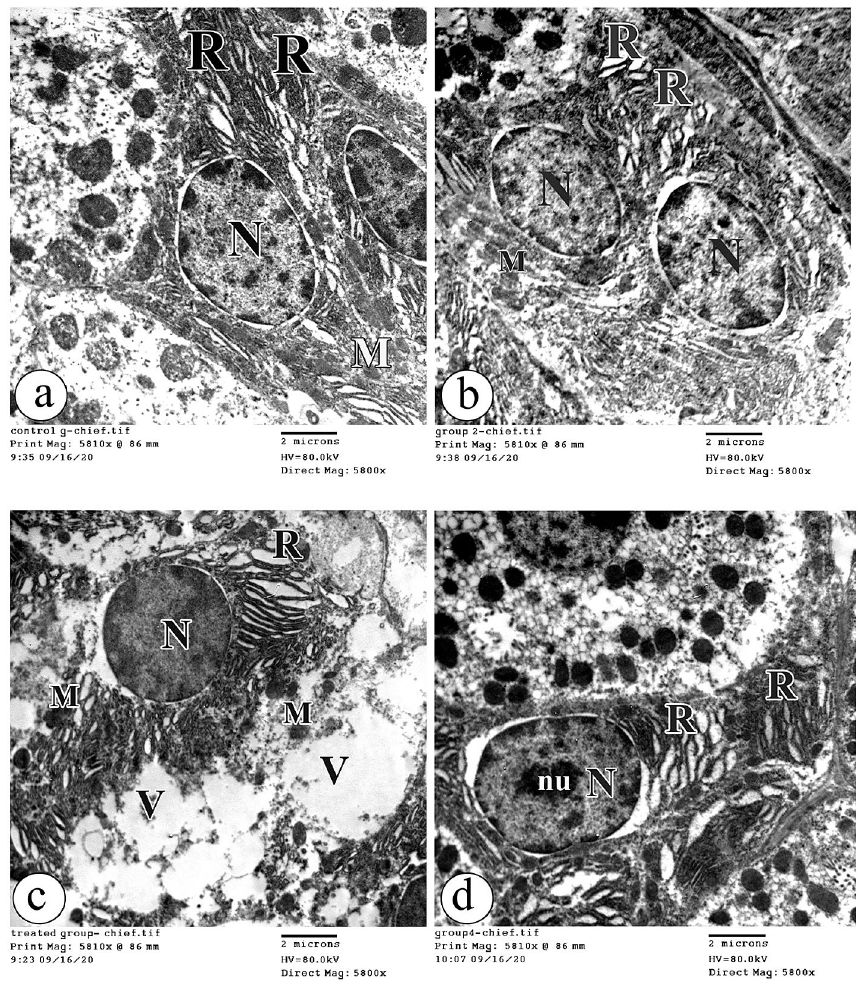
Figure 8. The electron photomicrographs of the Chief cell in ( a ) the group Ӏ showing an euchromatic nucleus (N), mitochondria (M) and an abundant packed rough endoplasmic reticulum (R). ( b ) the group ӀӀ showing an ultrastructural morphology as in the group Ӏ . ( c ) the group ӀӀӀ showing an electron dense nucleus (N), electron dense mitochondria (M) and many vacuolations (V). Dilatation and elongation of the rough endoplasmic reticulum (R) are observed. ( d ) the group Ӏ V showing an electron dense nucleus (N) with nucleolus(nu) and a dilated rough endoplasmic reticulum (R). (TEM × 5800, Scale bar = 2